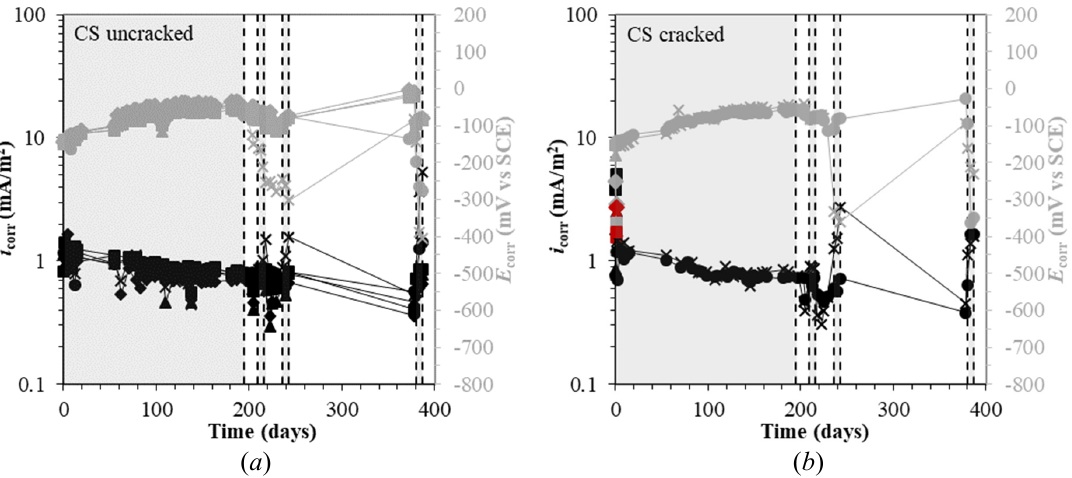
Figure 2. Evolution in time of the corrosion potential (grey symbols) and corrosion current density (black sym- bols) of carbon steel bars embedded in the five replicate uncracked (a) and cracked (b) concretes and exposed to ponding with a 3.5% NaCl solution; red symbols in (b) corresponding to the interruption of exposure for corroding specimens.